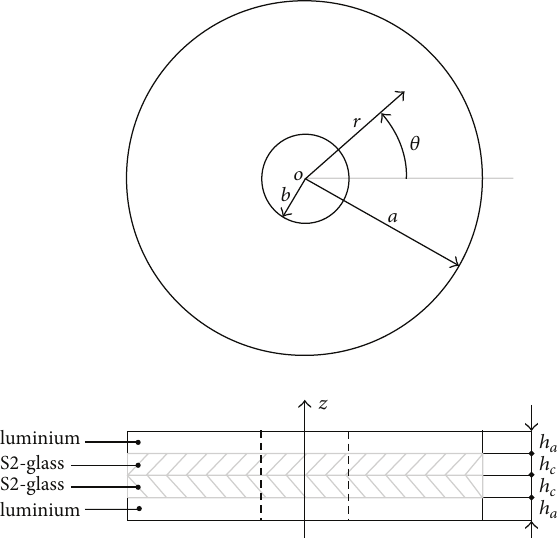
Figure1:Schematicviewofacircularfibermetallaminateplatewith a central